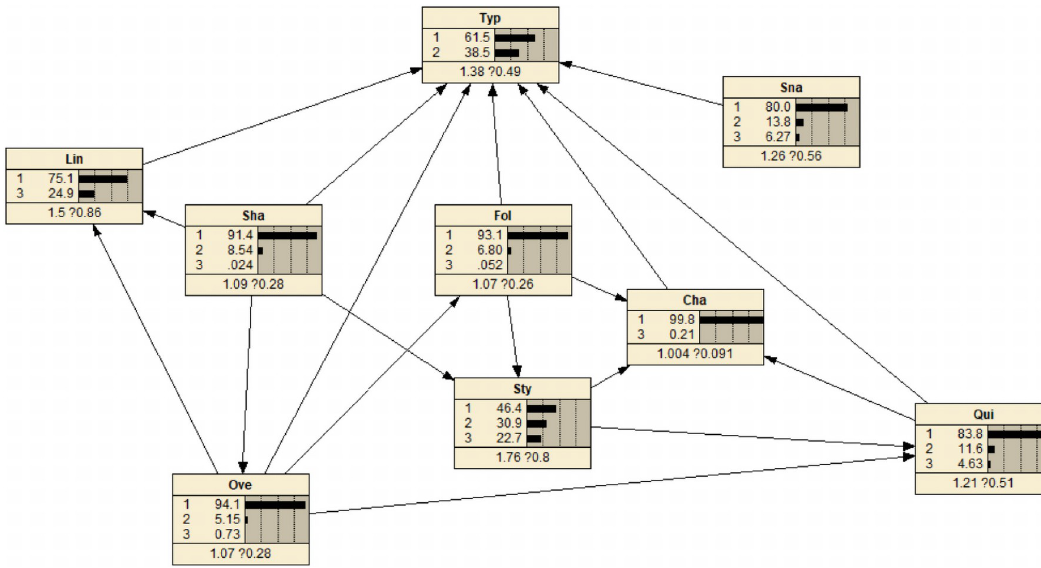
Fig 8. Bayesian network model after learning with Netica software